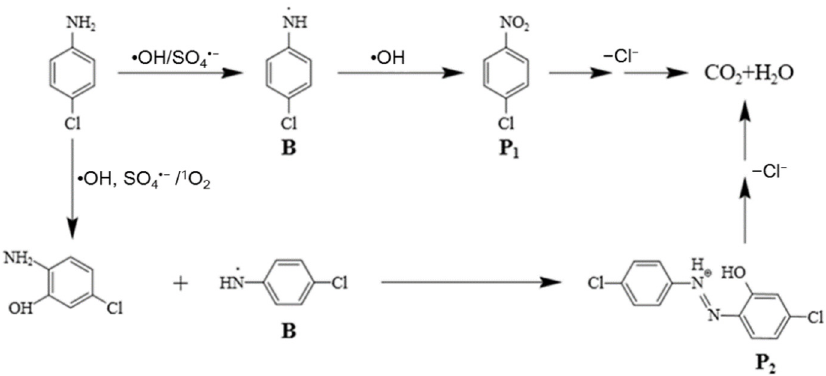
Figure 8. Possible degradation pathways of PCA in the MnFe 2 O 4 /PDS system.